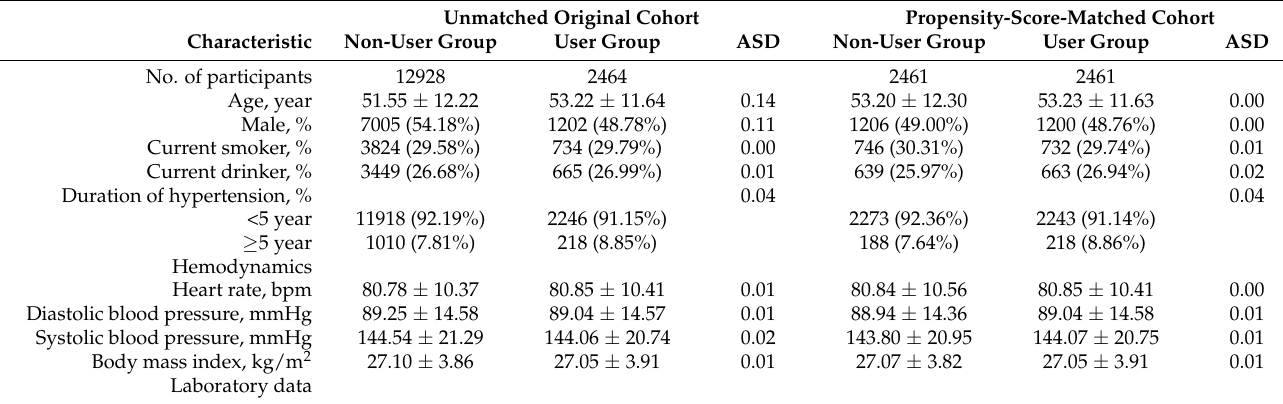
Table 1. Characteristics of the study